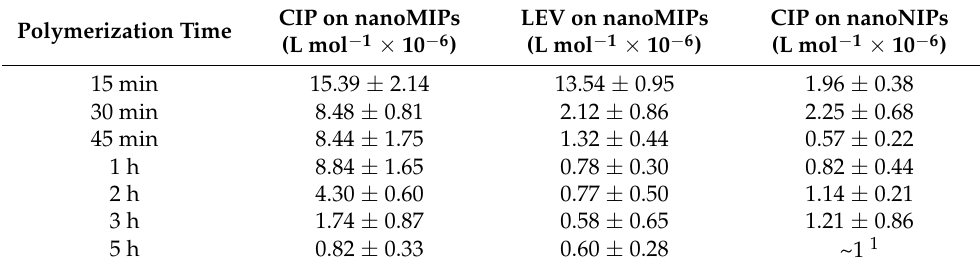
Table 2. Equilibrium binding constants ( ± 1 standard error unit) measured for ciprofloxacin and lev- ofloxacin on ciprofloxacin-imprinted nanoMIPs and ciprofloxacin on diclofenac-imprinted nanoMIPs (nanoNIPs). Underlined values: statistically indistinguishable from the corresponding results ob- tained on